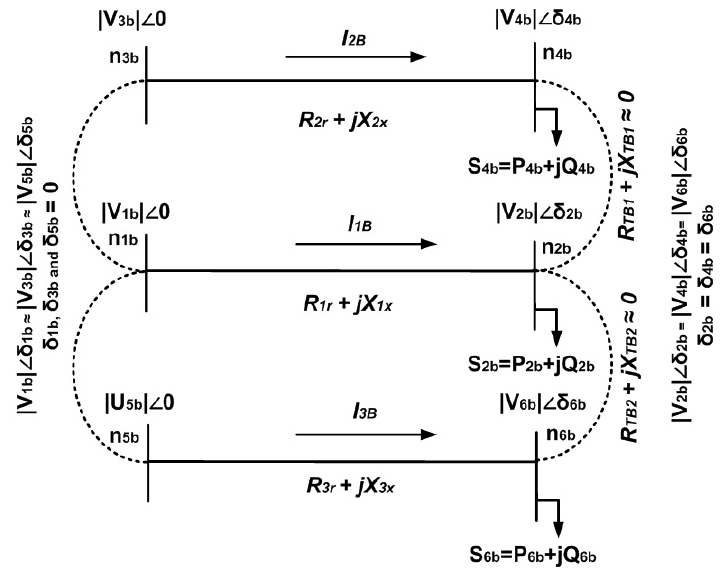
Figure 1. Electrical equivalent diagram of mesh distribution network [30,31].